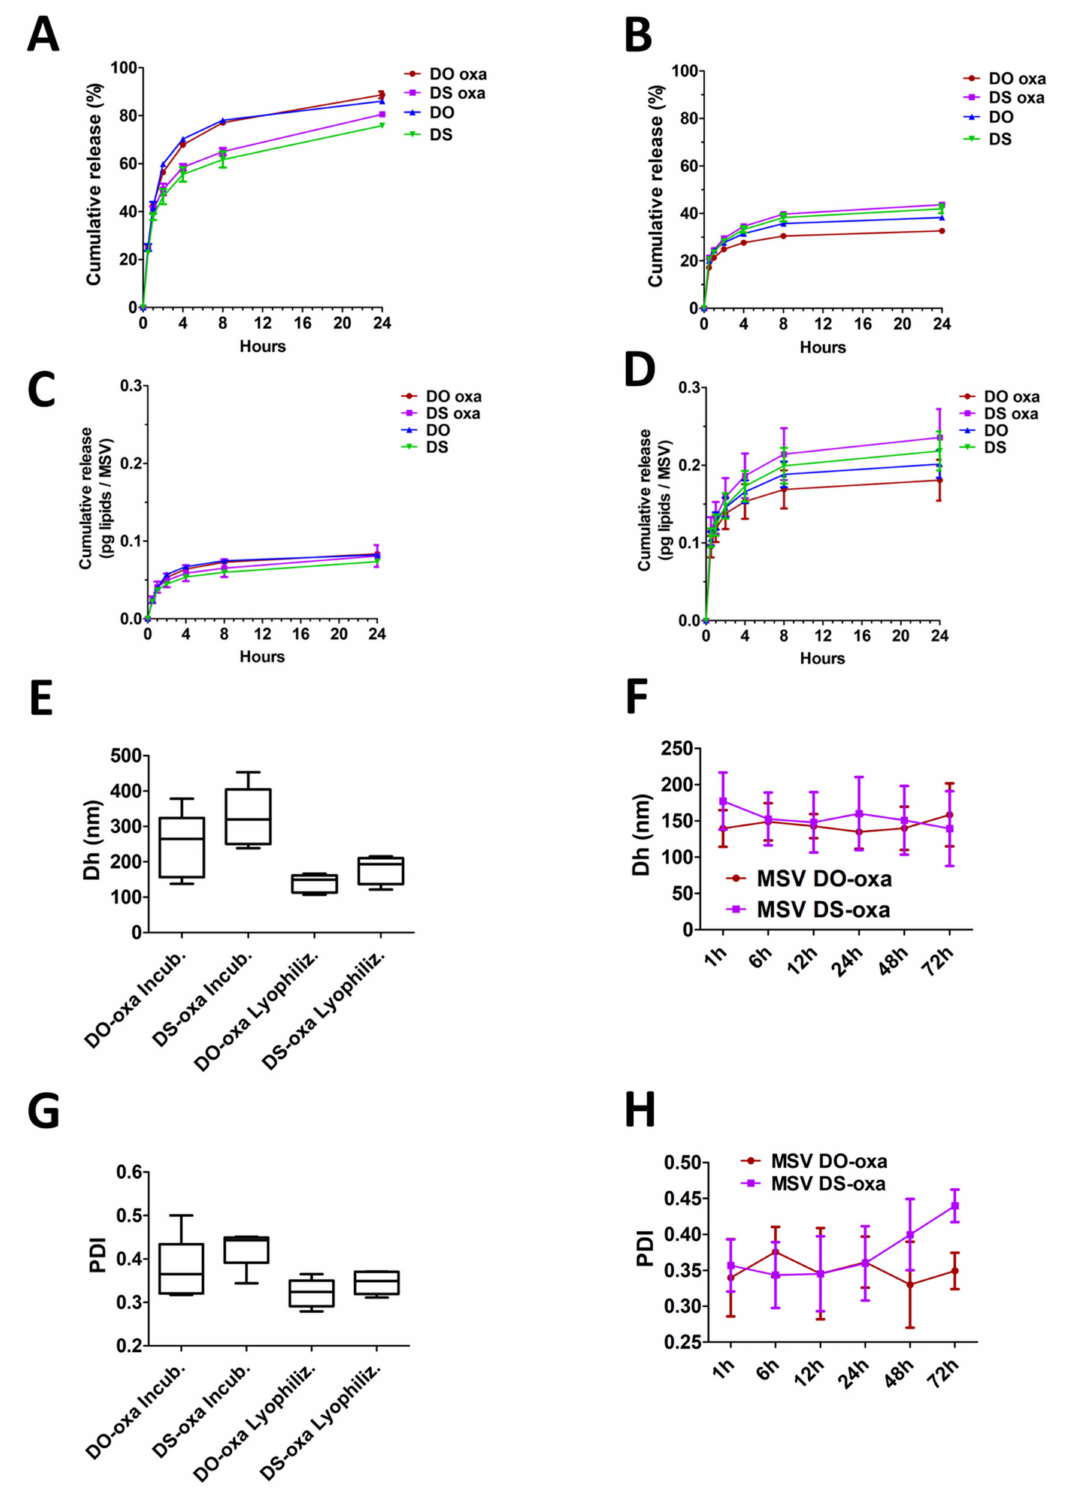
Figure 7. Release of liposomes from the MSV. Kinetics of cumulative release of liposomes from the MSV; percentage of liposomes released after loading ( A ) by incubation and ( B ) by lyophilization; picograms of lipids released after loading ( C ) by incubation and ( D ) by lyophilization. Experiments were performed in three independent replicates; ( E ) hydrodynamic diameter (Dh, nm) of oxa-liposomes released from the MSV after 1 h; ( F ) Dh of lyophilized liposomes released from the MSV in a time-course analysis; ( G ) polydispersion index (PDI) of oxa-liposomes released from the MSV after 1 h; (H) PDI of lyophilized liposomes released from the MSV in a time-course analysis. Experiments were performed in five independent replicates. Error bars represent standard